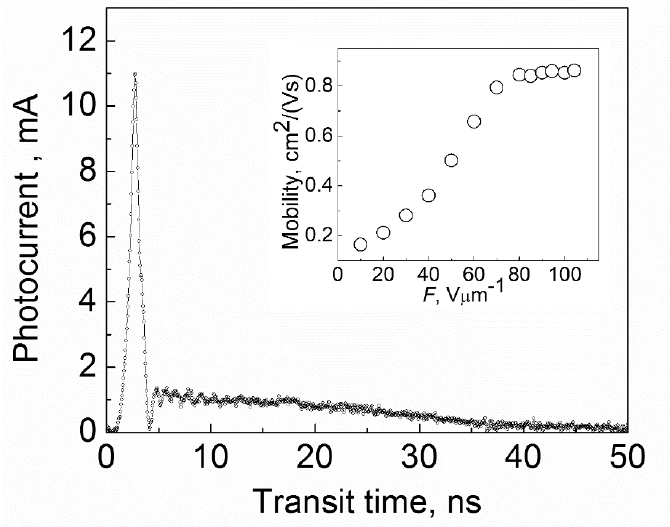
Figure 16. TOF signal from a-Se HARP blocking structure with a RIL in avalanche regime for F = 100 V µm −1 . The inset shows the dependence of the drift mobility on the applied